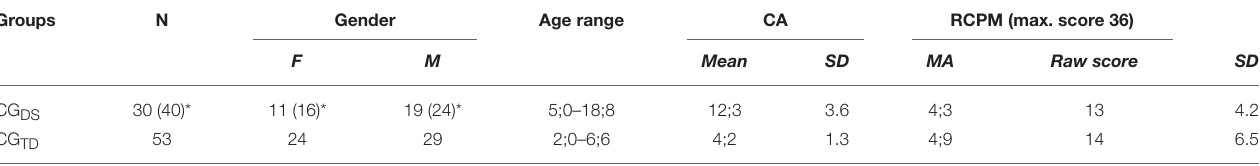
TABLE 1 | Participant Information for CG children with DS and CG children with TD. Groups N Gender Age range